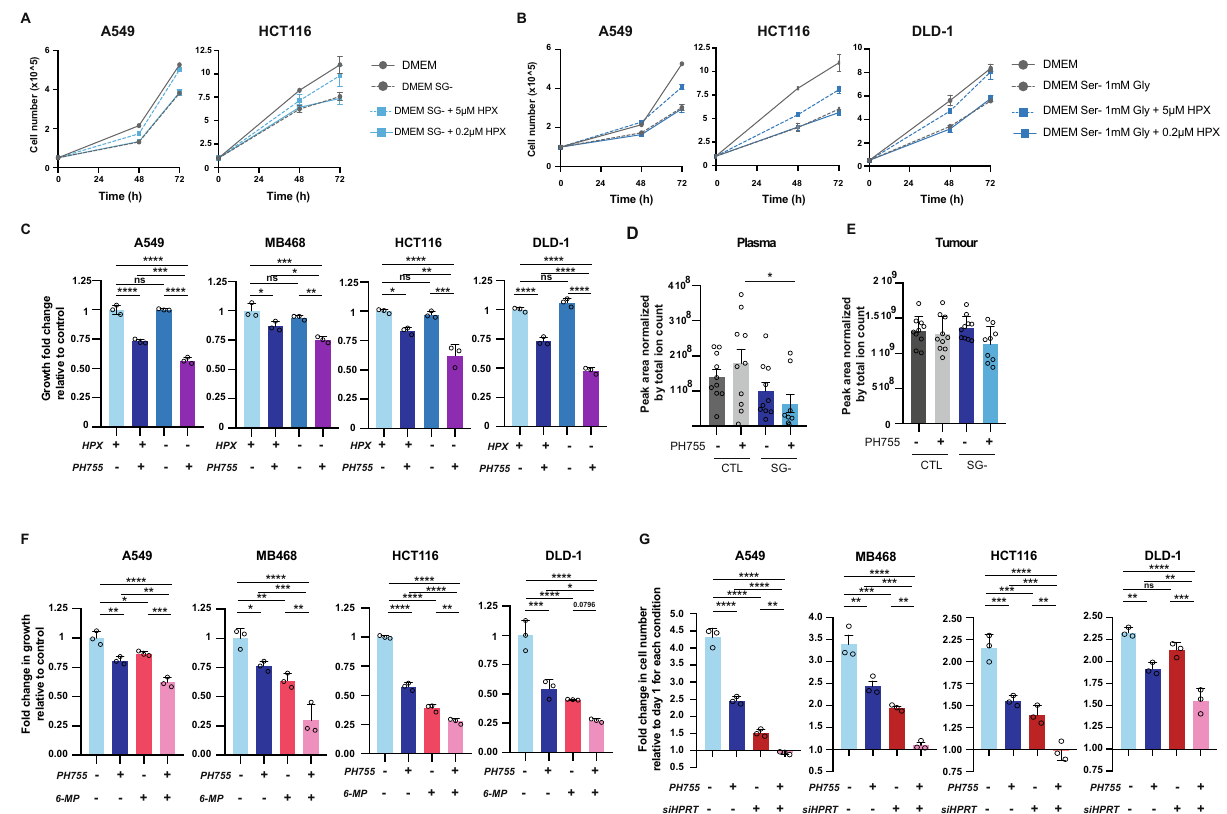
Fig. 4 Cooperation between serine synthesis pathway inhibition and modulation of hypoxanthine in limiting tumour cell growth. A Growth curve of cells grown in DMEM lacking serine and glycine (-SG) supplemented (blue) or not (grey) with 5 or 0.2 µ M of hypoxanthine. Data are represented as mean ± SD of triplicate wells and representative of 3 independent experiments. B Growth curve of cells grown in DMEM lacking serine ( − S) but containing 1 mM glycine ( + 1 mM G) supplemented (blue) or not (grey) with 5 or 0.2 µ M of hypoxanthine. Data are represented as mean ± SD of triplicate wells and representative of 3 independent experiments. C Growth fold change relative to the untreated Plasmax condition (HPX + /PH755 − ) after 72 h of proliferation in the different conditions. Cells were treated with 10 µ M PH755 where indicated. Data are represented as mean ± SD of triplicate wells and representative of three independent experiments (one-way Anova, * p < 0.05, ** p < 0.01, *** p < 0.001, **** p < 0.0001, ns: no signi fi cance). D , E Levels